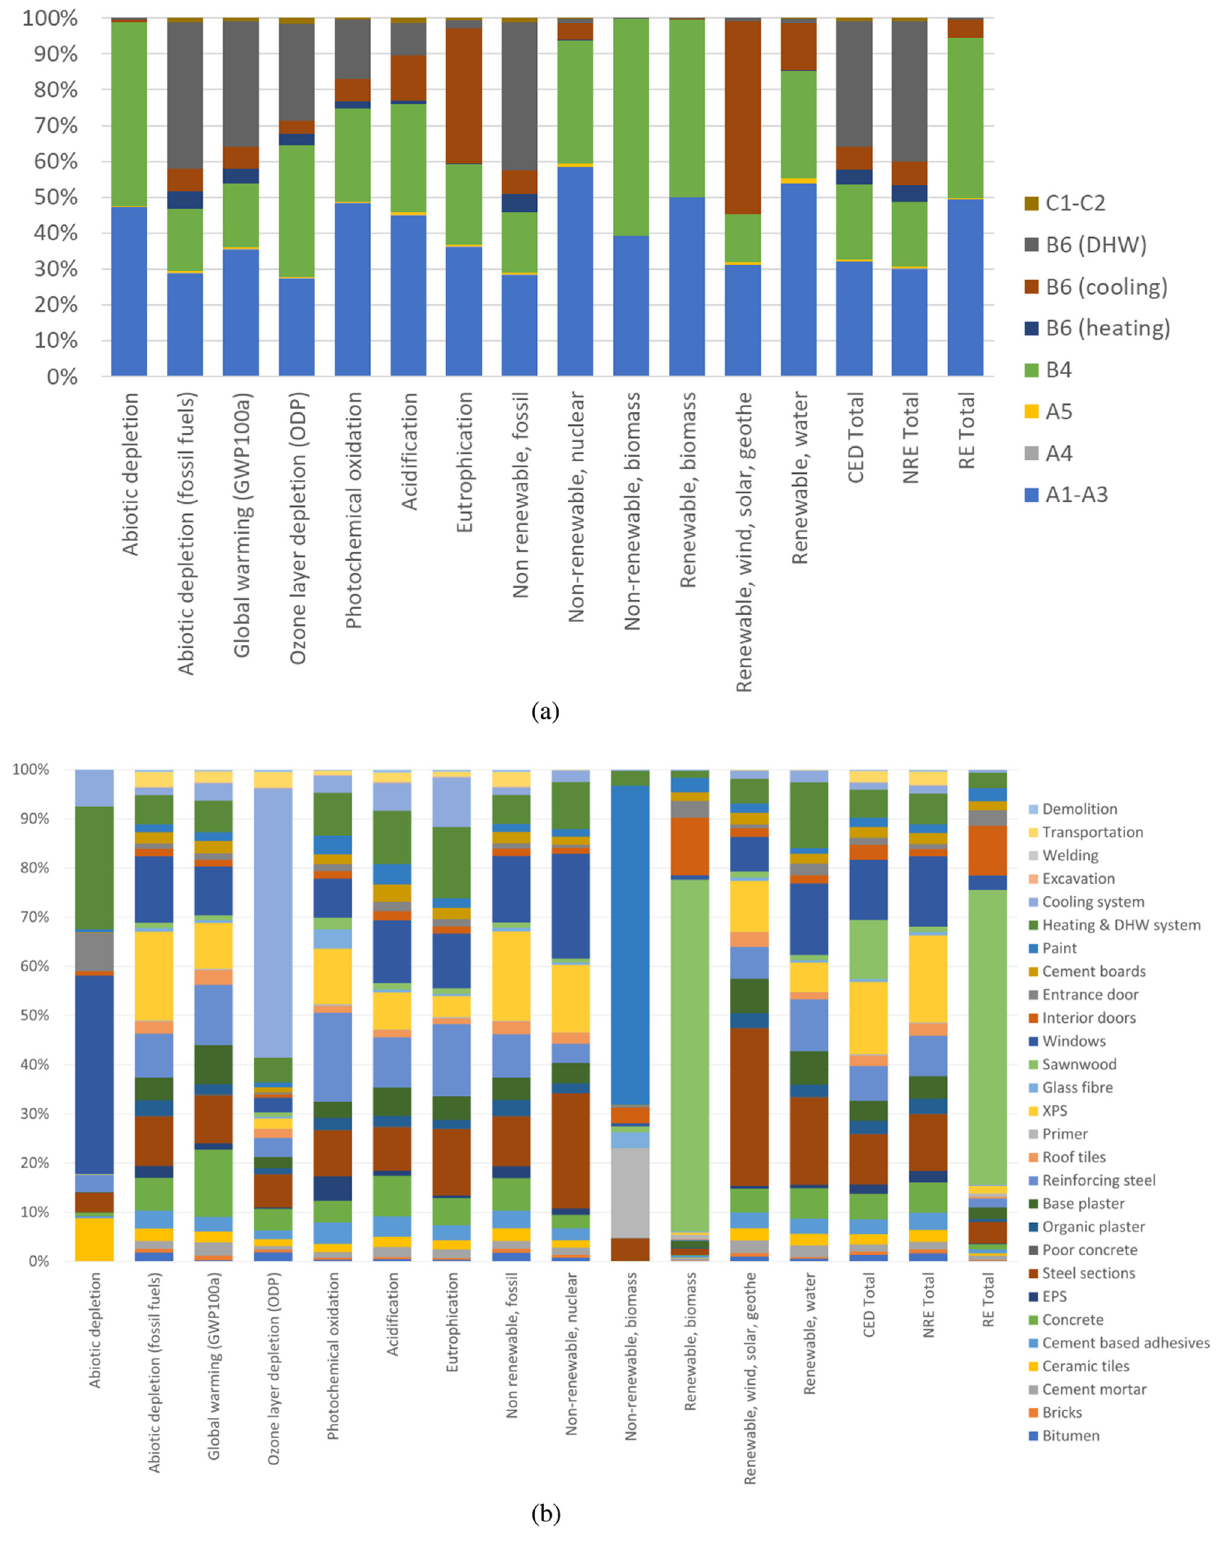
Fig. 4. Percentage contribution to the life cycle impact: (a) per life cycle process and (b) per material/component, within the system boundaries of the prefabricated building (base case scenario: no PCM, XPS 10cm thickness and climate zone A of